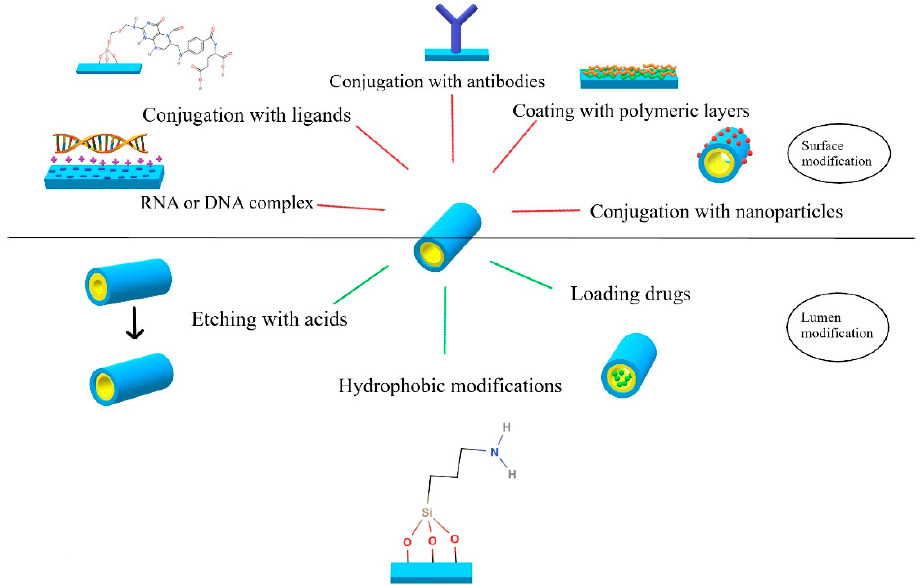
Figure 2. HNT modifications designed for effective delivery of anticancer drugs.